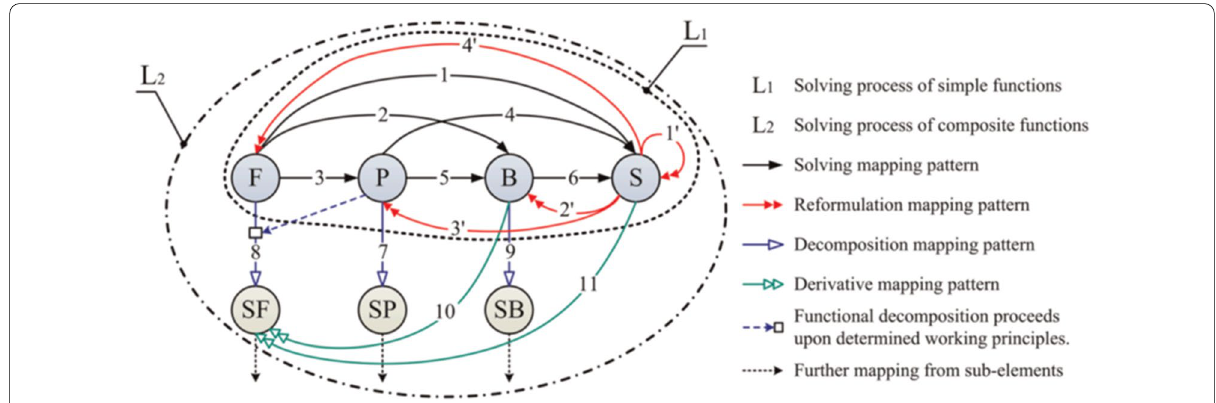
Figure 1 Configuration of human upper limb and its equivalent mechanical